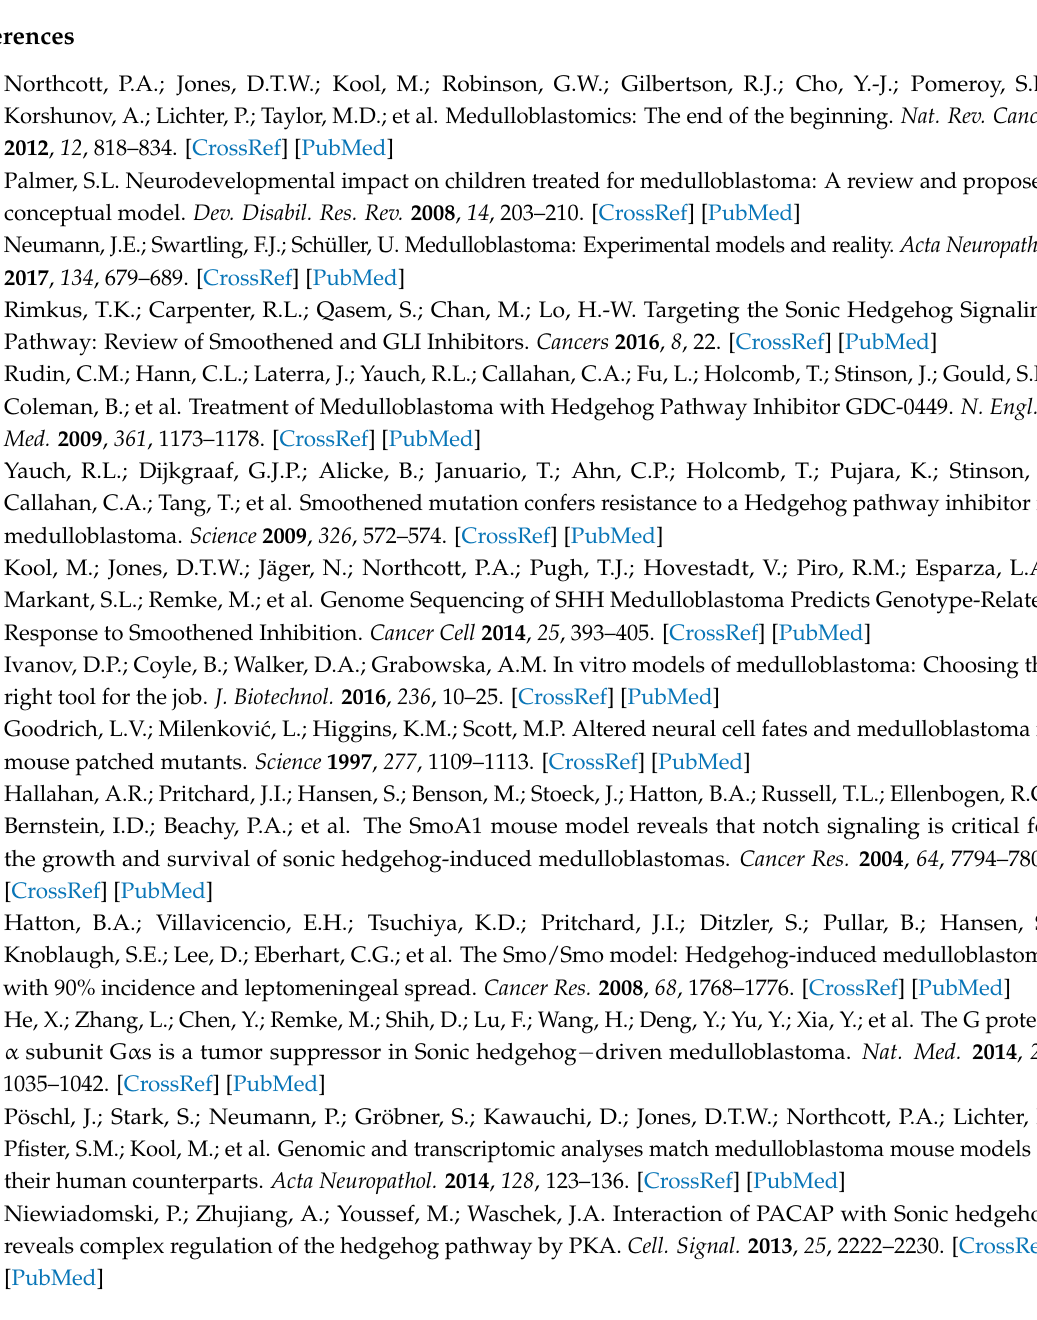
(FWER—family-wise error rate). Table S3. Top GSEA categories for genes upregulated in mouse but not human SHH-MB analyzed taking healthy cerebellar tissues as controls (FWER–family-wise error